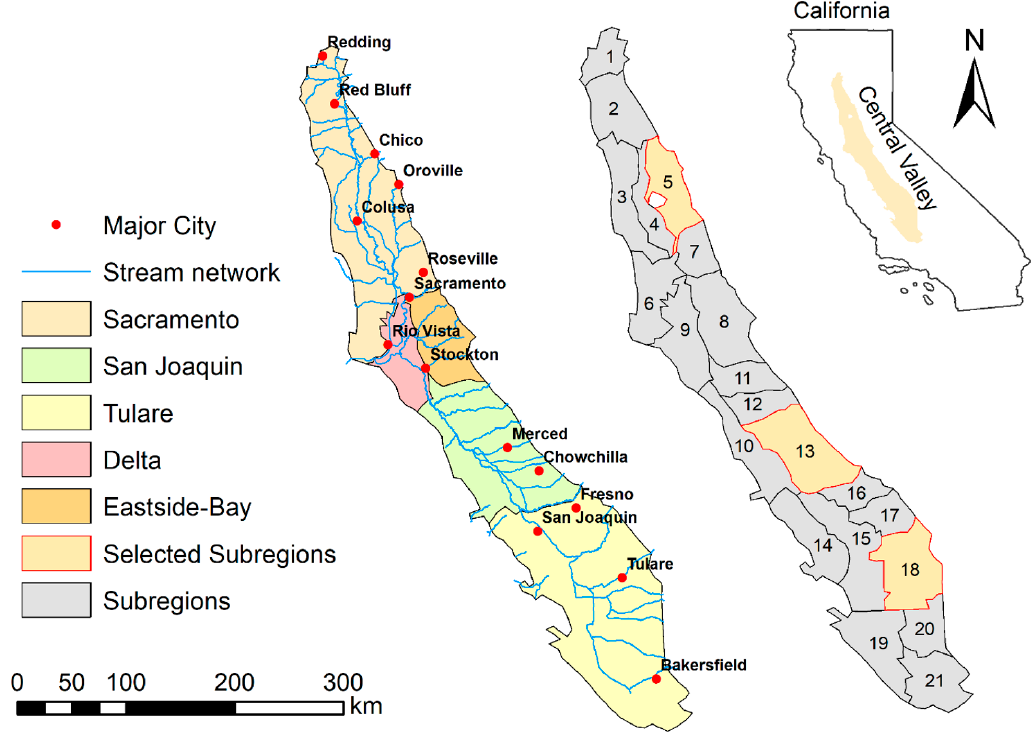
Figure 1. The map shows major cities and hydrologic regions ( left ), and Subregions ( right ) in the Central Valley, California. The highlighted subregions in the right are the selected subregions for this study (subregion 5, 13 and 18).